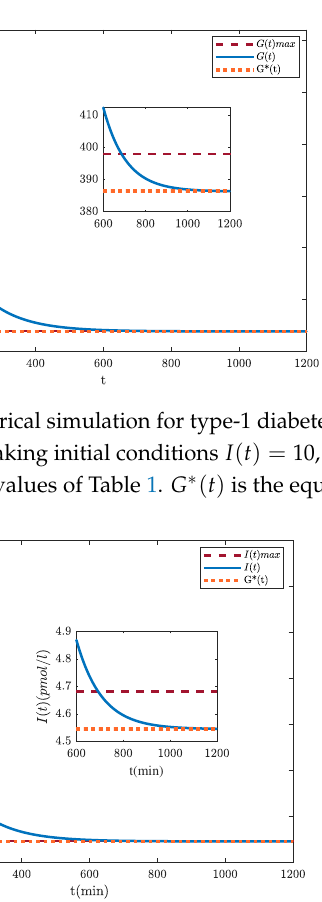
Figure 3. Numerical simulation for type-1 diabetes mellitus system (1)–(5): Solution for I ( t ) (plasma insulin variation), taking initial conditions I ( t ) = 10, Y ( t ) = 10, D ( t ) = 800, G ( t ) = 800, and U ( t ) = 550, and parameter values of Table 1. I ∗ ( t ) is the equilibrium point, and I max is the up- per